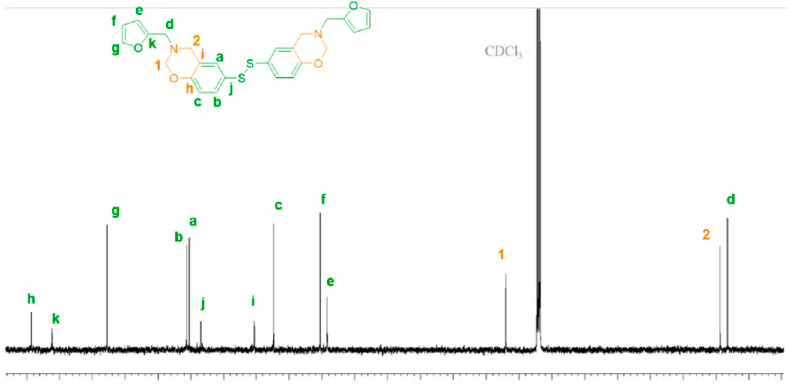
Figure A2. 1 H NMR spectrum in CDCl 3 of 3DPDS-fa.